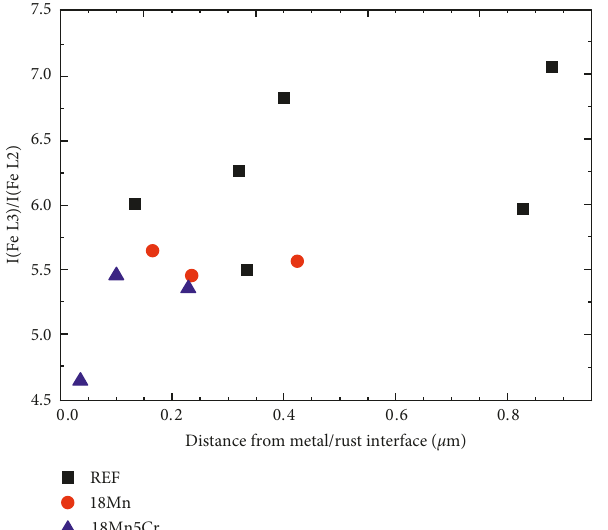
Figure 9: Integral intensity ratio of Fe L3 edge peak to Fe L2 edge peak depending on the distance from the metallic surface of REF, 18Mn, and 18Mn5Cr presented in Table 6.